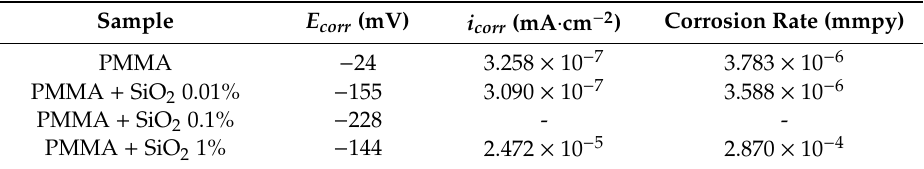
Figure 8. ( a ) Polarization curves of the PMMA coatings and images of the metallic sheets cover for: ( b ) PMMA + SiO 2 0.01%, ( c ) PMMA + SiO 2 0.1%, ( d ) PMMA + SiO 2 1% coatings, and ( e ) 3D image of the a ff ected zone for the corrosion process. Table 3. Corrosion parameters for the PMMA coatings in 3.5 wt% NaCl solution.